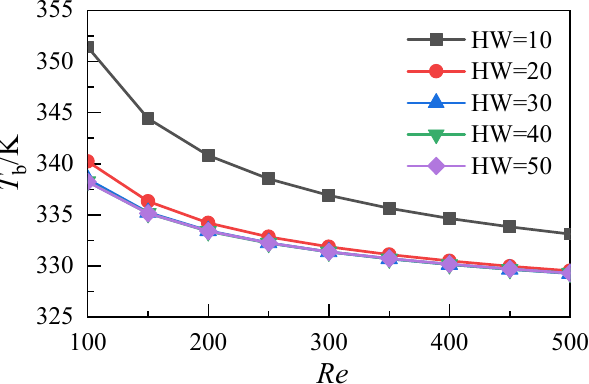
Figure 11. Distributions of friction coefficients.